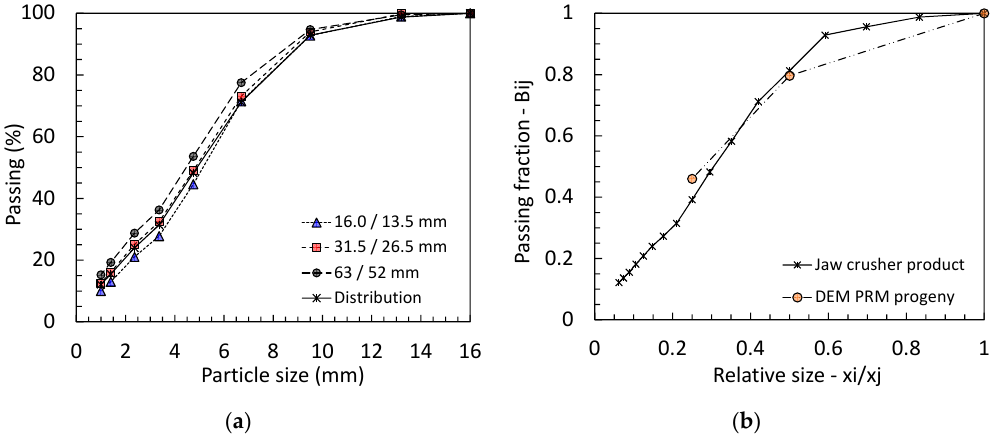
Figure 7. Product size distributions from laboratory jaw crushing tests with di ff erent feeds ( a ) and DEM PRM daughter spheres distribution modeled ( b